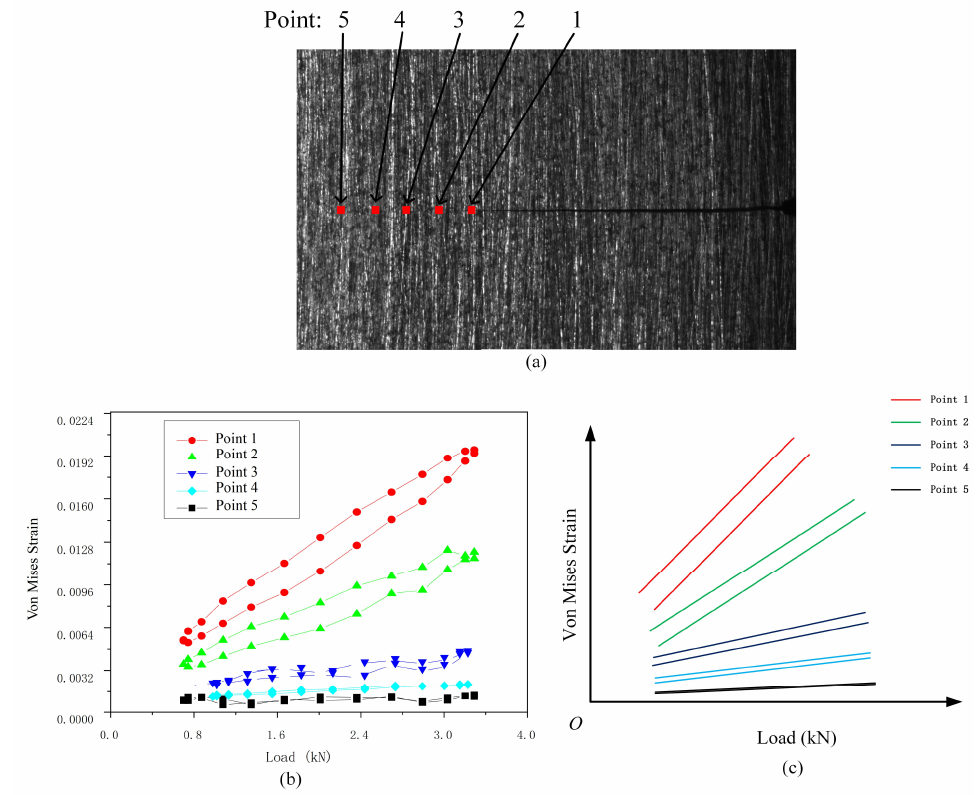
Figure 11. Load–strain distribution at different distances from the crack tip of Q&P 980 steel: ( a ) Measure points layout; ( b ) load–strain curve near the crack tip; ( c ) abstracted load–strain